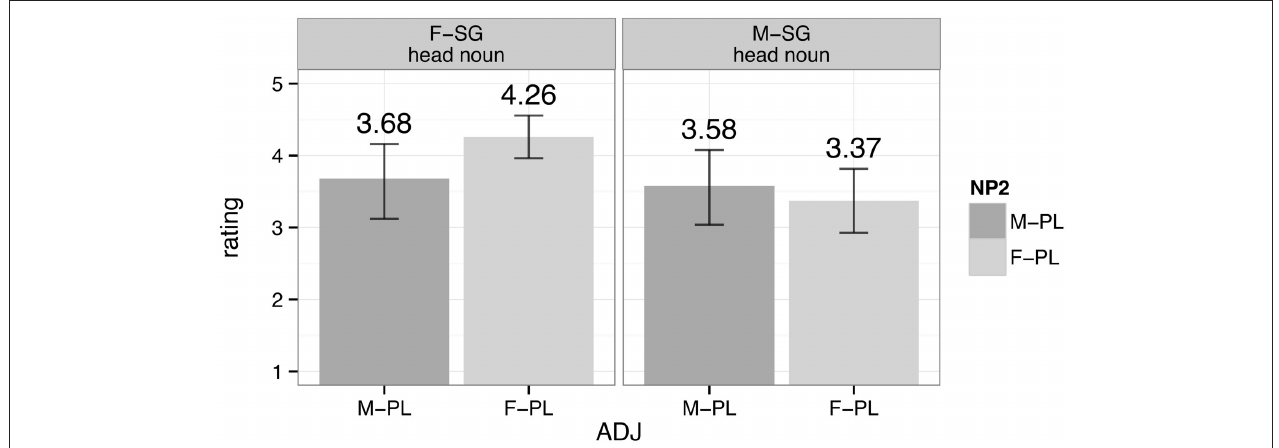
FIGURE 1 | Average ratings for potential attraction conditions (Fuchs et al., in